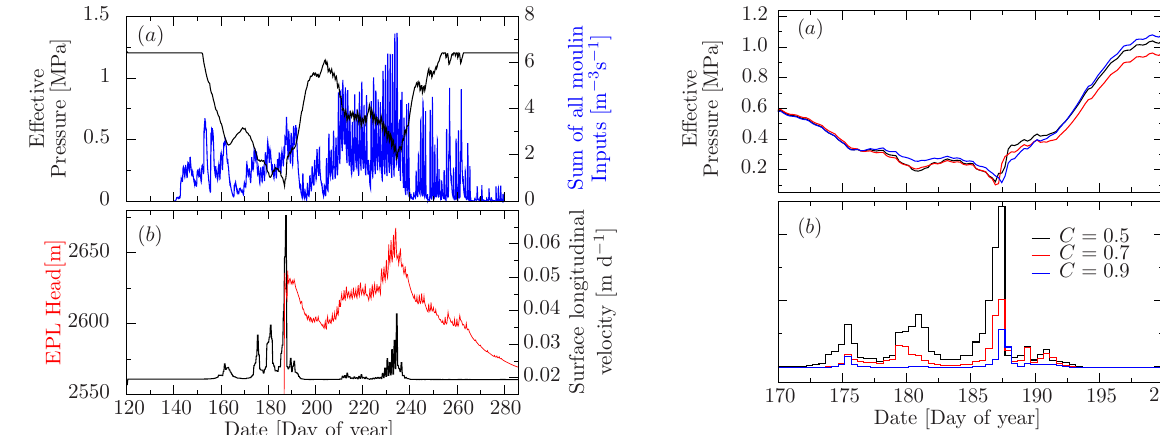
Fig. 12. Evolution throughout the melt season at the reference point depicted in Fig. 4 of (a ) the effective pressure (left axis, black curve) and the water input (right axis, blue curve), (b) the sur- face longitudinal velocity. The simulation is performed with A s = 1 . 6 × 10 − 23 mPa − 3 s − 1 and C = 0 . 5.